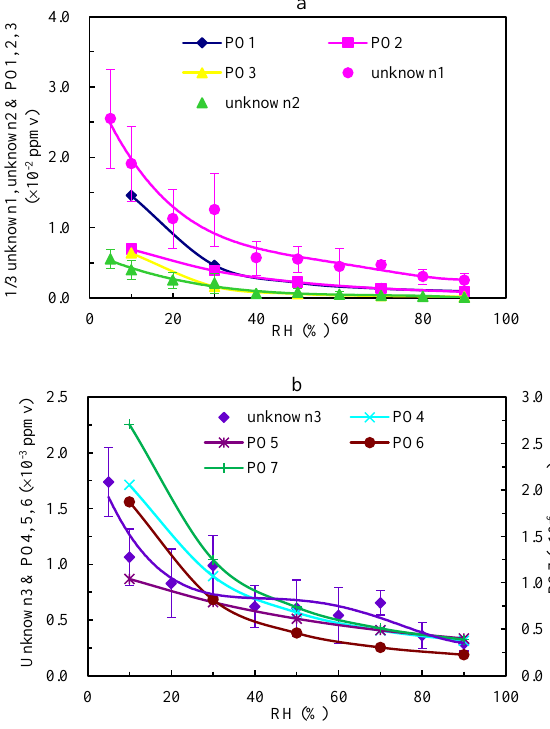
Fig. 8. The simulated dependence of the concentrations of seven POs on the relative humidity (RH), and comparisons between the modelled PO and the observed unknown peroxides. (a) Observed unknown1, unknown2, and modelled PO1, 2, and 3. (b) Observed unknown3 and modelled PO4, 5, 6, and